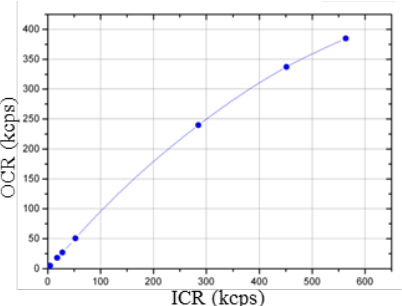
Figure 3 – High count rate capability of system Ø10 mm x 10 mm CeBr 3 + SiPM with Topaz-SiPM MCA, applying short shaping times (RT=0.8, FT=1). The radiation source sample was a technetium-99 bottle (figure given by the manufacturer).